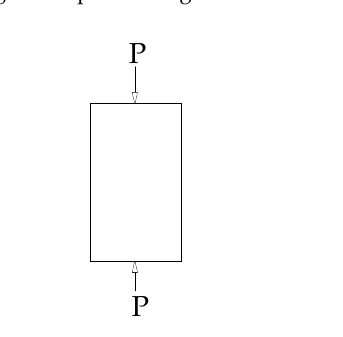
Figure 6. Schematic diagram of the uniaxial condition of the pillar.